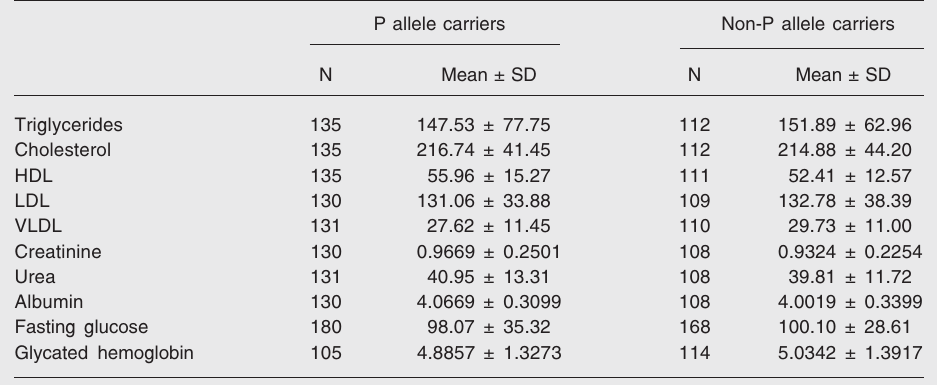
Table 3. Descriptive statistics concerning P allele and non-P allele carriers and laboratory